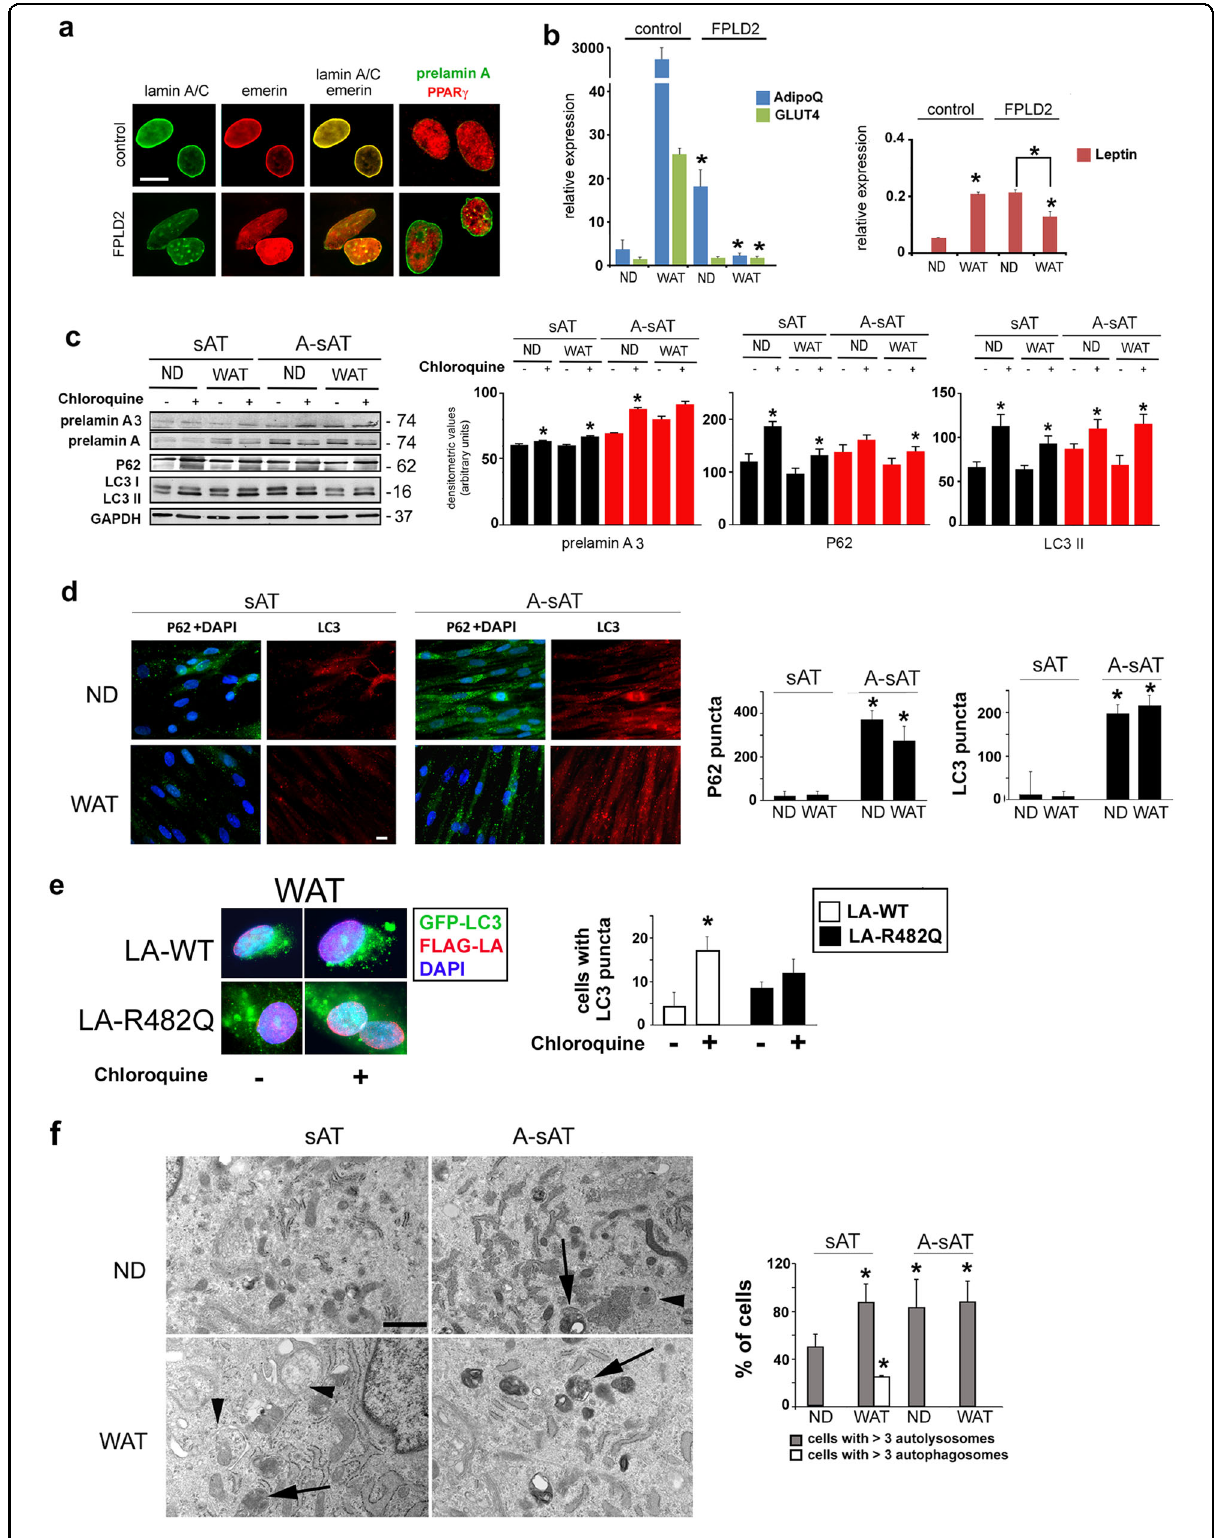
Fig. 2 (See legend on next